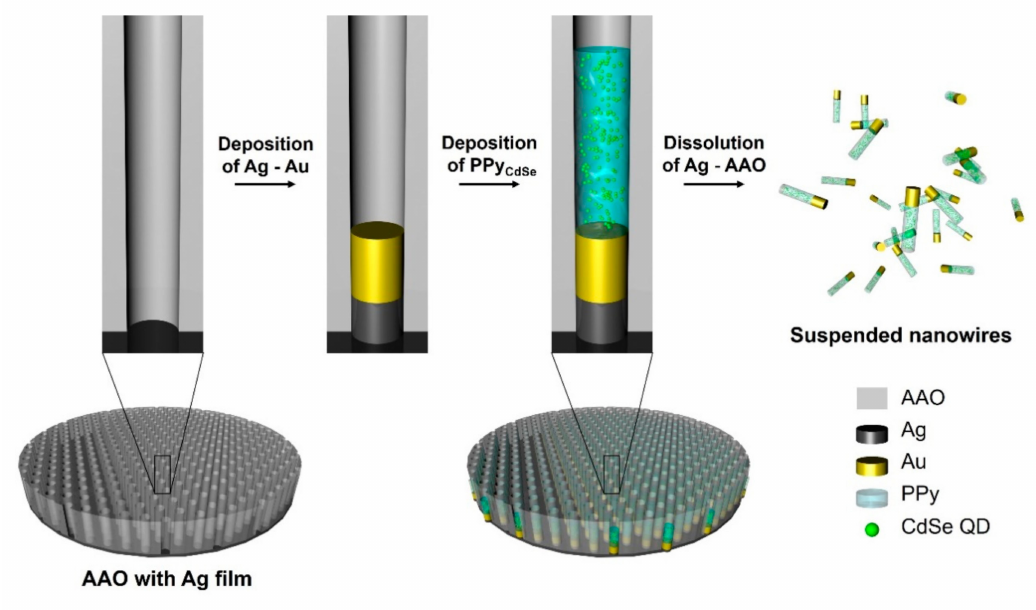
Figure 1. Schematic illustration of synthetic procedures for the CdSe-embedded PPy